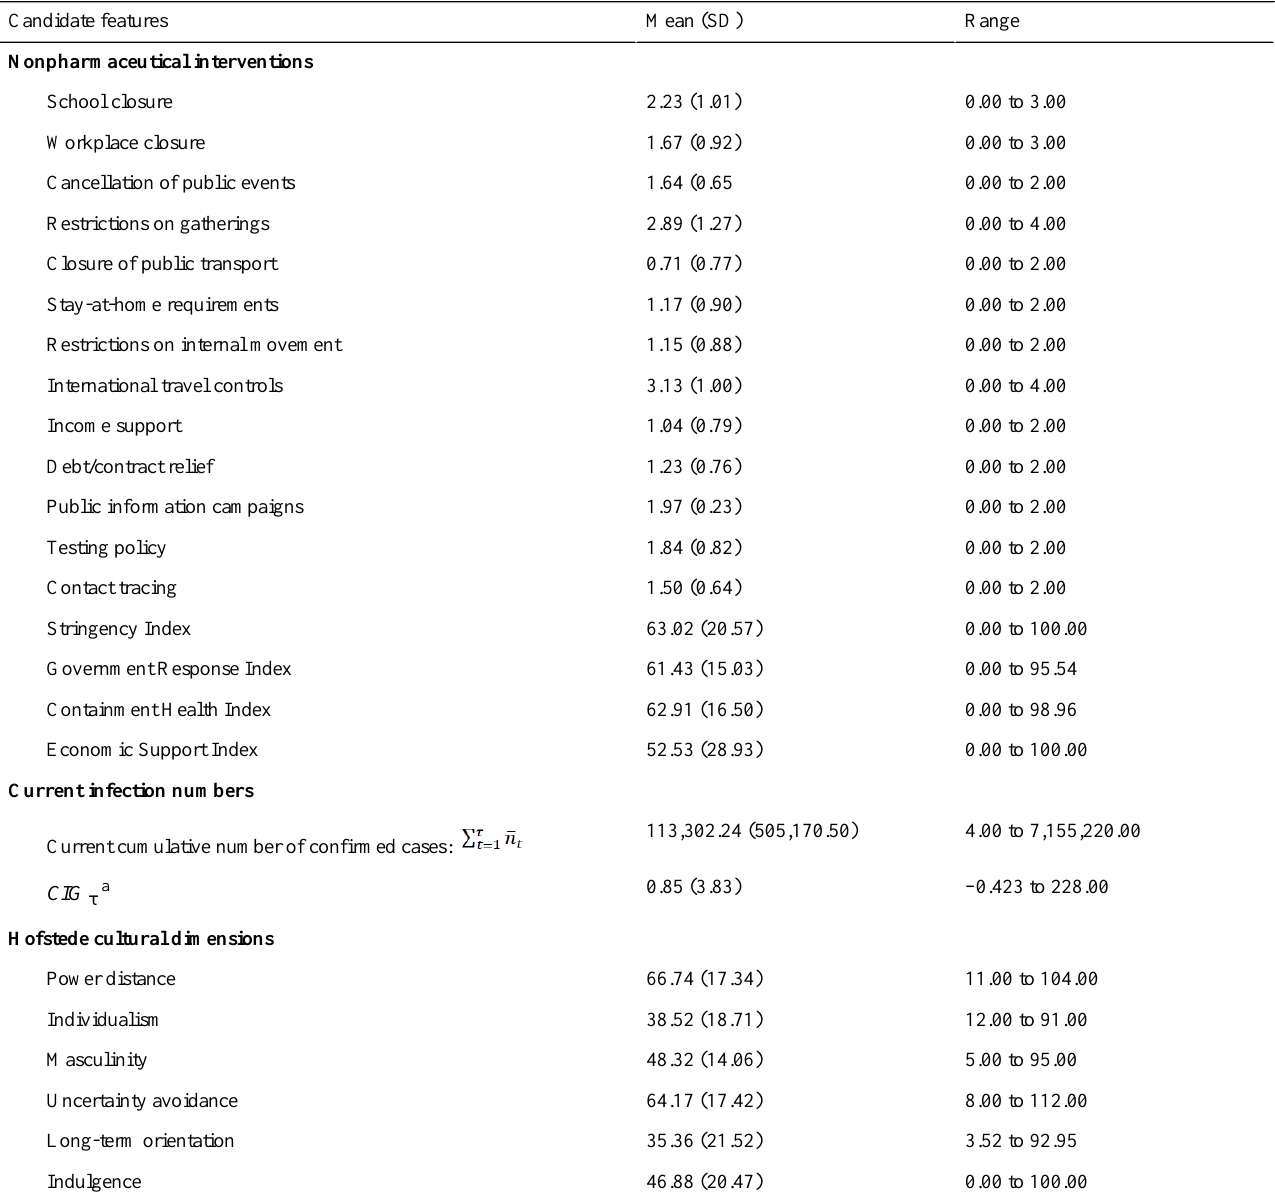
Table 1. Statistical measurements of candidate feature